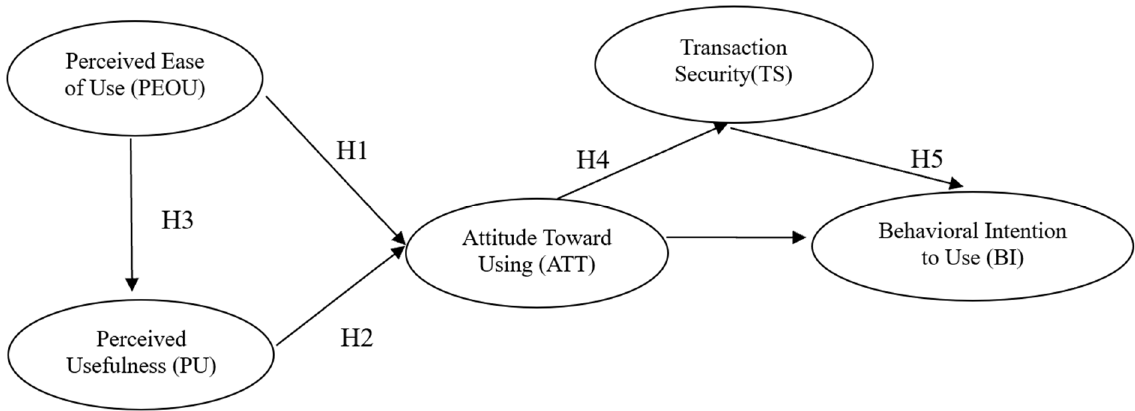
Figure 2. Conceptual